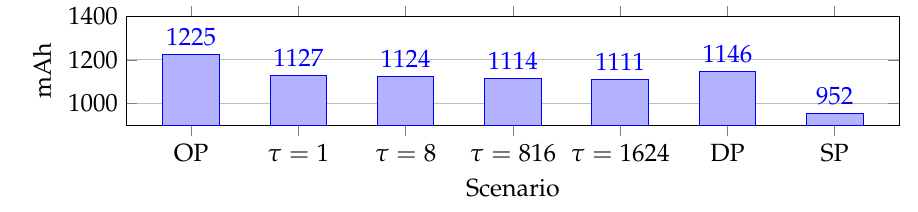
Figure 15. Average current